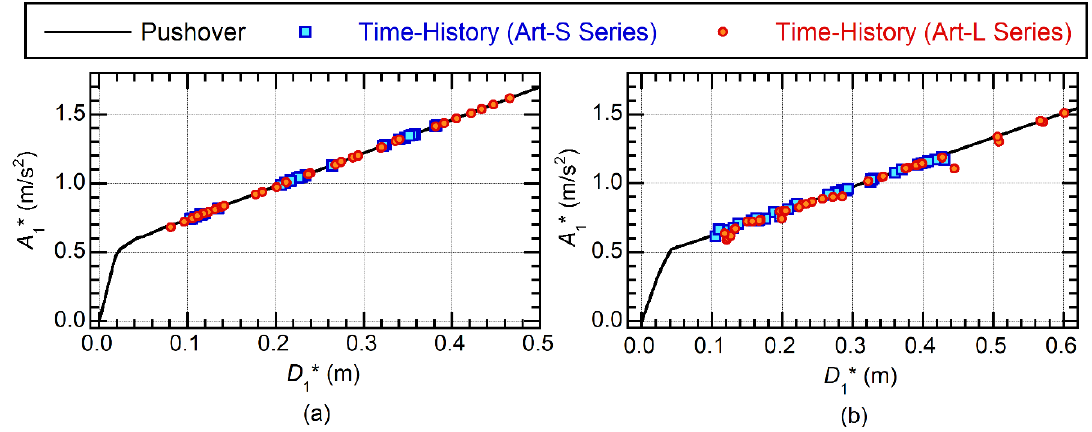
Figure 10. Comparison of the relationships of A 1 * versus D 1 * calculated from the pushover analysis results and the peak of nonlinear time-history analysis: ( a ) Model-05 and ( b ) Model-14.